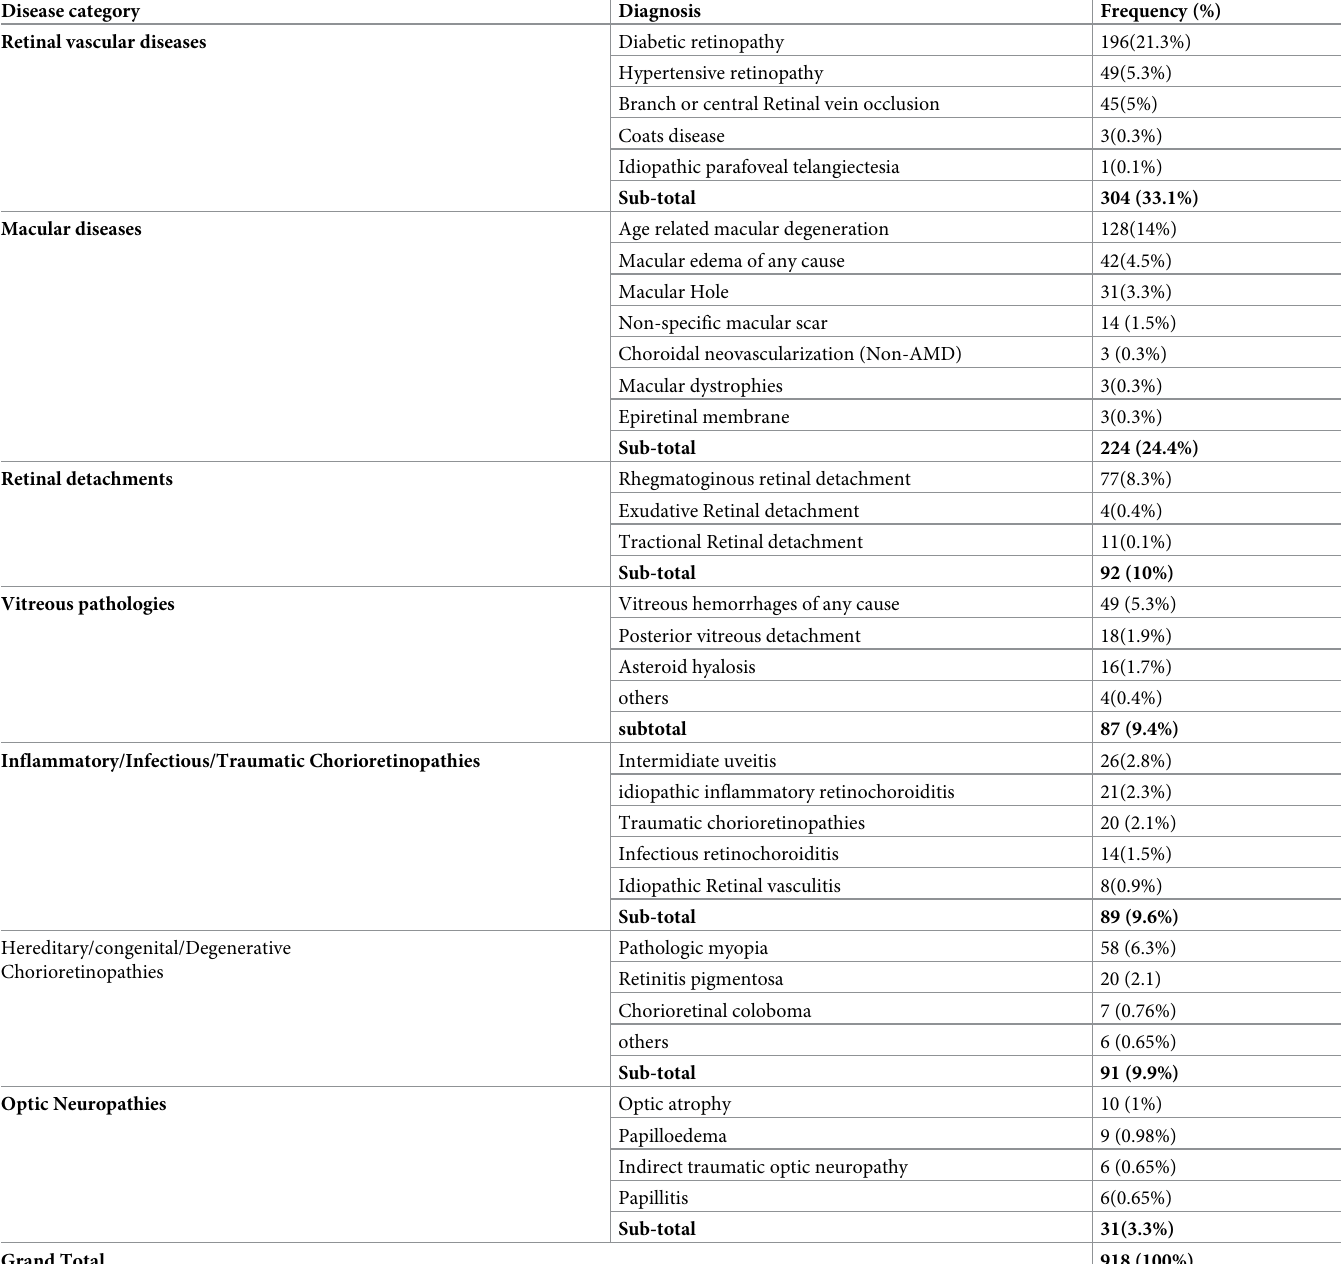
Table 3. Category and vitreoretinal diagnoses made among patients presented to the University of Gondar Tertiary eye care and training center, vitreo-retina clinic, Ethiopia. (N =